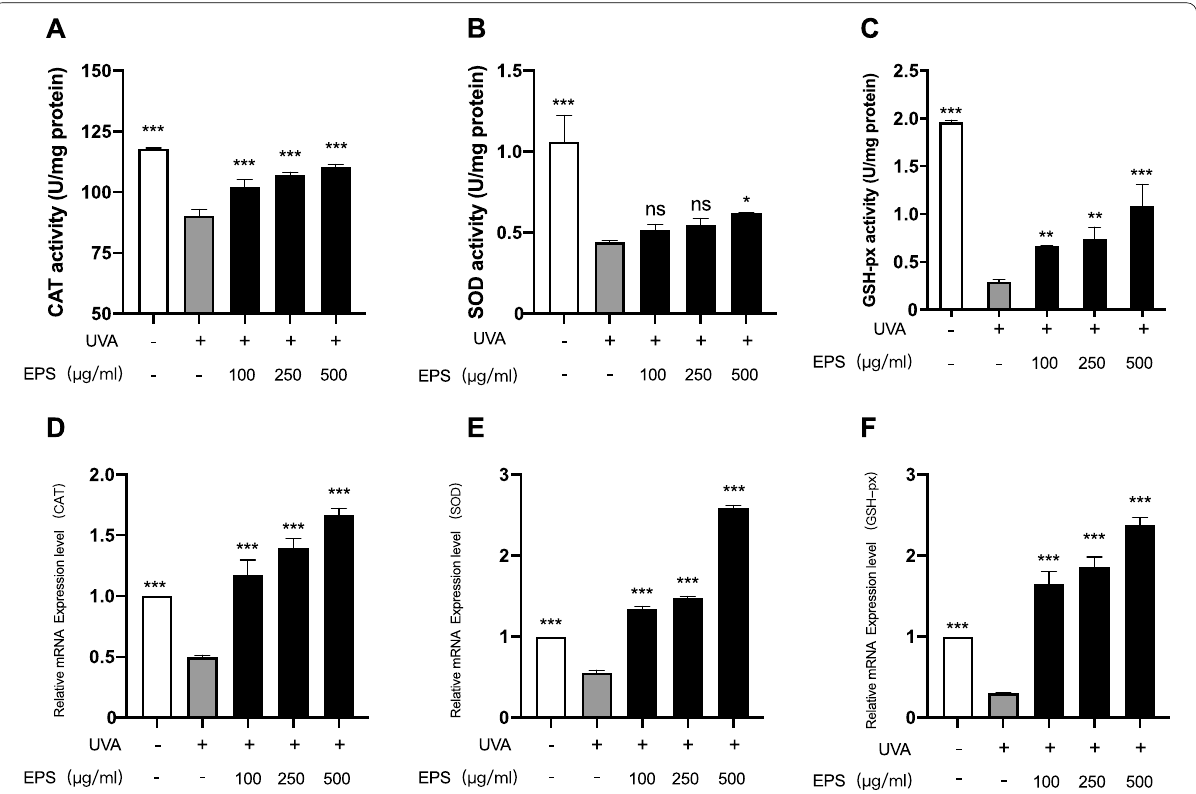
Fig. 4 Effects of different concentrations of EPS on antioxidant enzymes CAT ( A ), SOD ( B ) and GSH-px ( C ) in HSF under UVA irradiation. Relative mRNA expression levels of CAT ( D ), SOD ( E ) and GSH-px ( F ) under UVA irradiation after treatment with different concentrations of EPS. Each mRNA was referenced to the internal control gene β-actin and expressed relative to the control group. * p < 0.05, ** p < 0.01, *** p < 0.001 compared to model